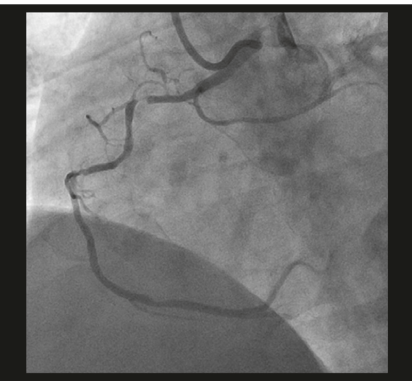
Figure 1: The left anterior oblique coronary angiography view showed severe calcified stenosis of the proximal segment of the right coronary artery (RCA) with anomalous origin.